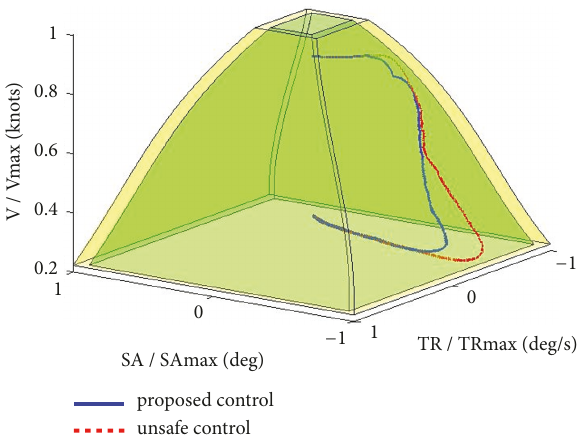
Figure 6: The variations of 𝑇𝑅 and 𝑆𝐴 .